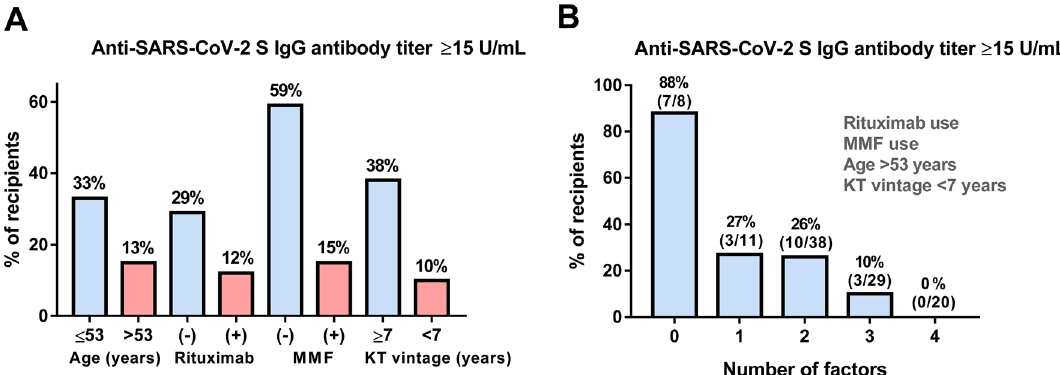
Figure 2. Comparison of rates of anti-SARS-CoV-2 S IgG seropositivity based on select factors. ( A ) Comparison of the anti-SARS-CoV-2 S IgG ≥ 15 U/mL rate based on age (≤ 53 vs. > 53 years), rituximab use (yes vs. no), KT vintage (≥ 7 vs. < 7 years). ( B ) Association between the number of risk factors and the rate of anti- SARS-CoV-2 S IgG ≥ 15